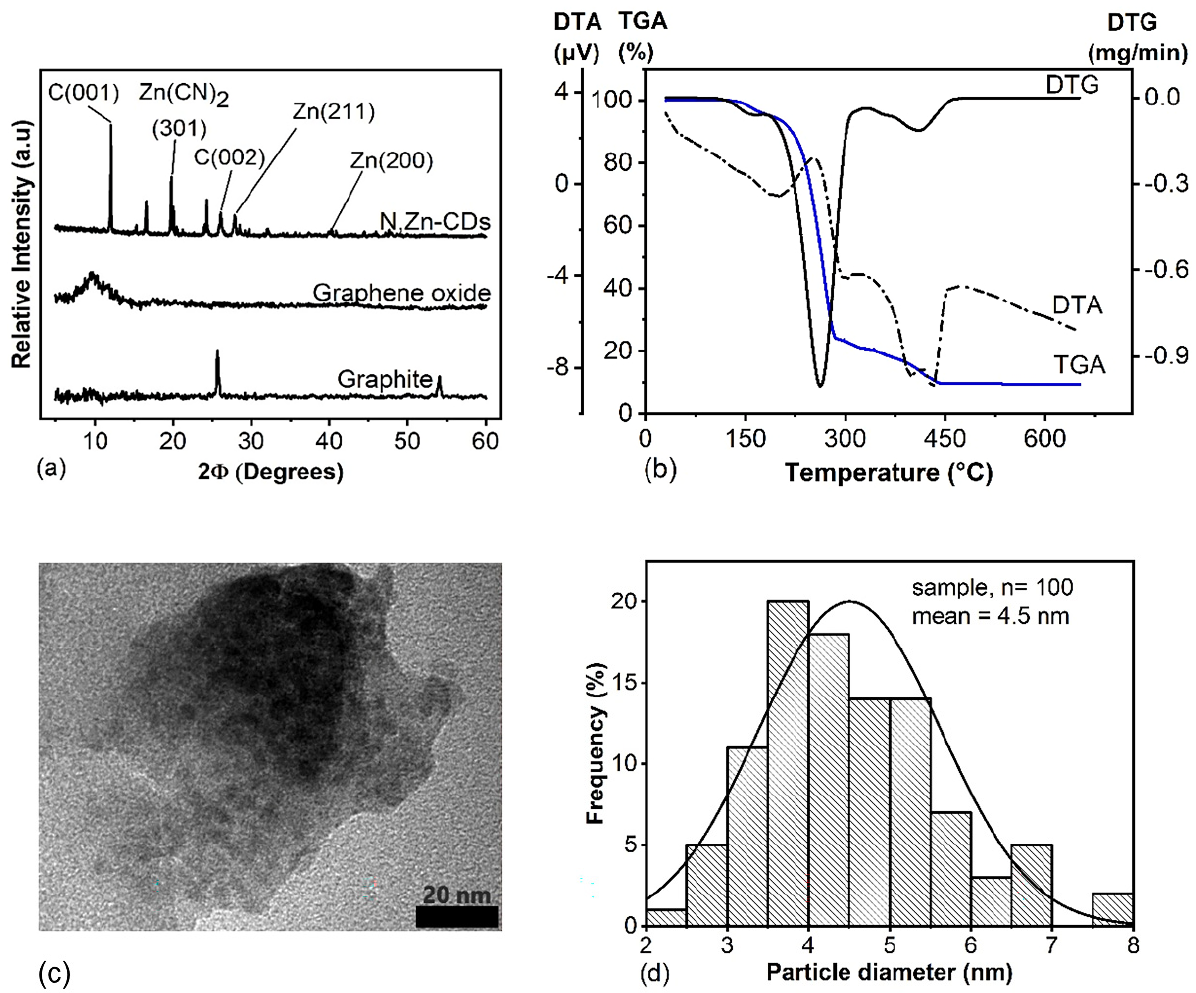
Figure 2. ( a ) XRD patterns for graphite and graphene oxide compared to the as-synthesized N,Zn- CDs, ( b ) TGA, DTA, and DTG patterns, ( c ) TEM image, and ( d ) particle size distribution of the as-synthesized N,Zn-CDs.